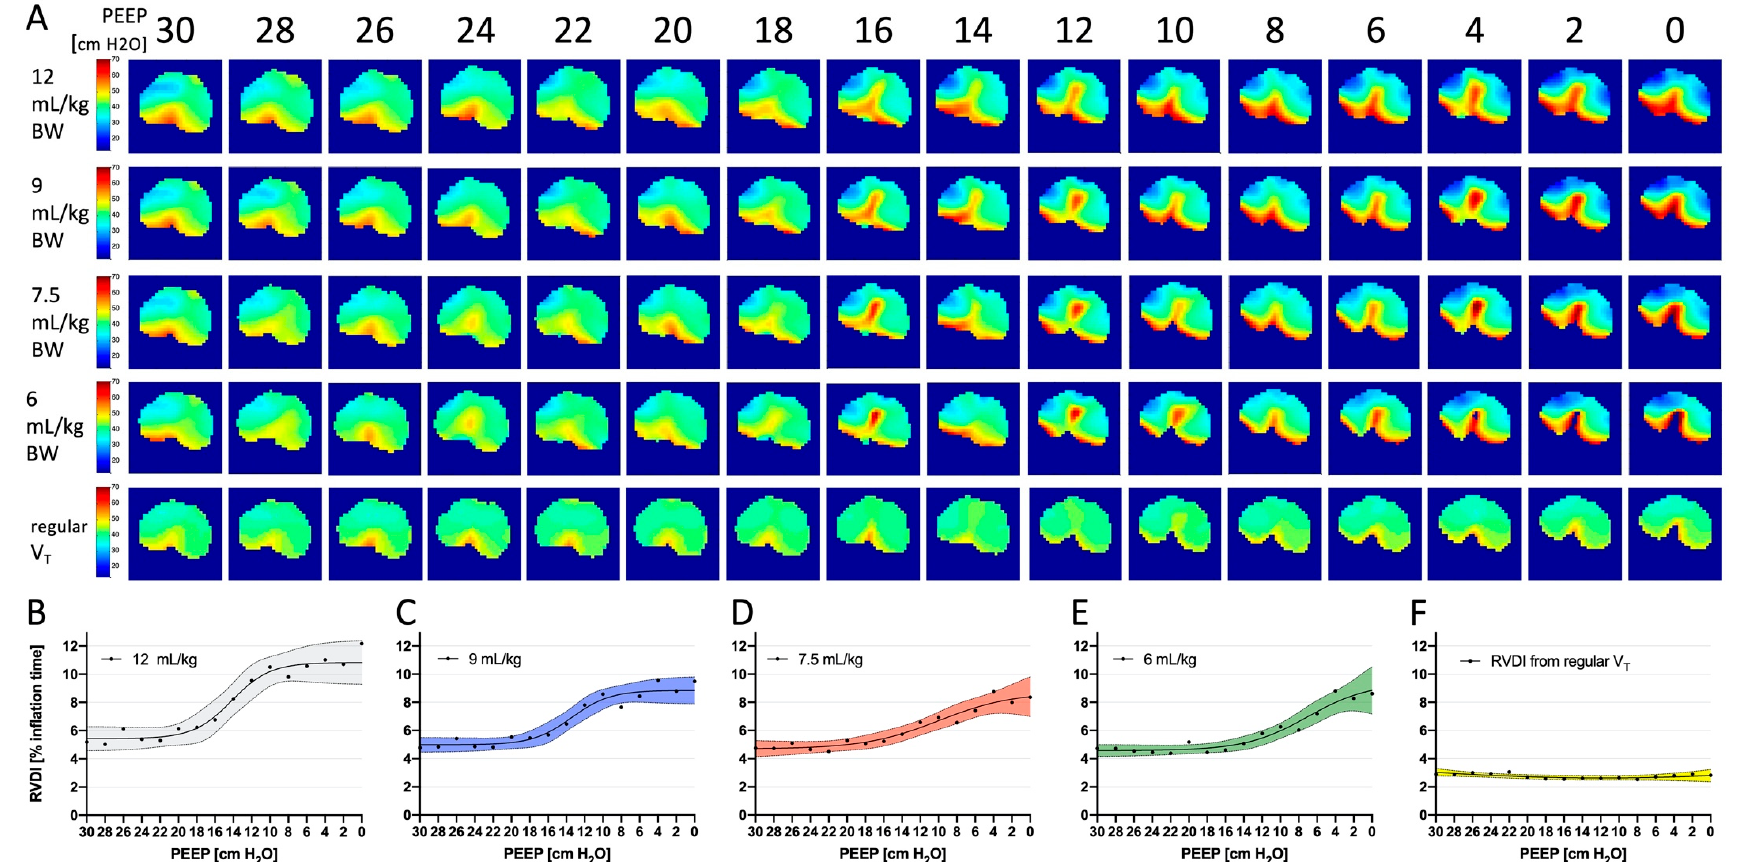
Figure 4. ( A ) Time disparities between regional impedance/time courses, displayed as color-coded regional ventilation delay (RVD) maps (as the percentage of inflation time) and calculated from slow inflation volumes of 12, 9, 7.5, and 6 mL/kg of body weight (BW), and regular tidal volume (V T ) on electrical impedance tomography (EIT); decremental positive end-expiratory pressure (PEEP) titration (30 to 0 cm H 2 O). Data of a representative animal. ( B – F ) Measures of regional ventilation delay inhomogeneity (RVDI; quantifying the inhomogeneity of the RVD maps) during the decremental PEEP trial obtained from 12 (gray), 9 (blue), 7.5 (red), and 6 (green) mL/kg, and regular V T (yellow). Black dots indicate means. Solid lines indicate a fitted polynomial curve of means. Dotted lines and colored areas demonstrate the 95% confidence interval. Note: x -axis shows decreasing PEEP values from 30 to 0 cm H 2 O according to the decremental trial.